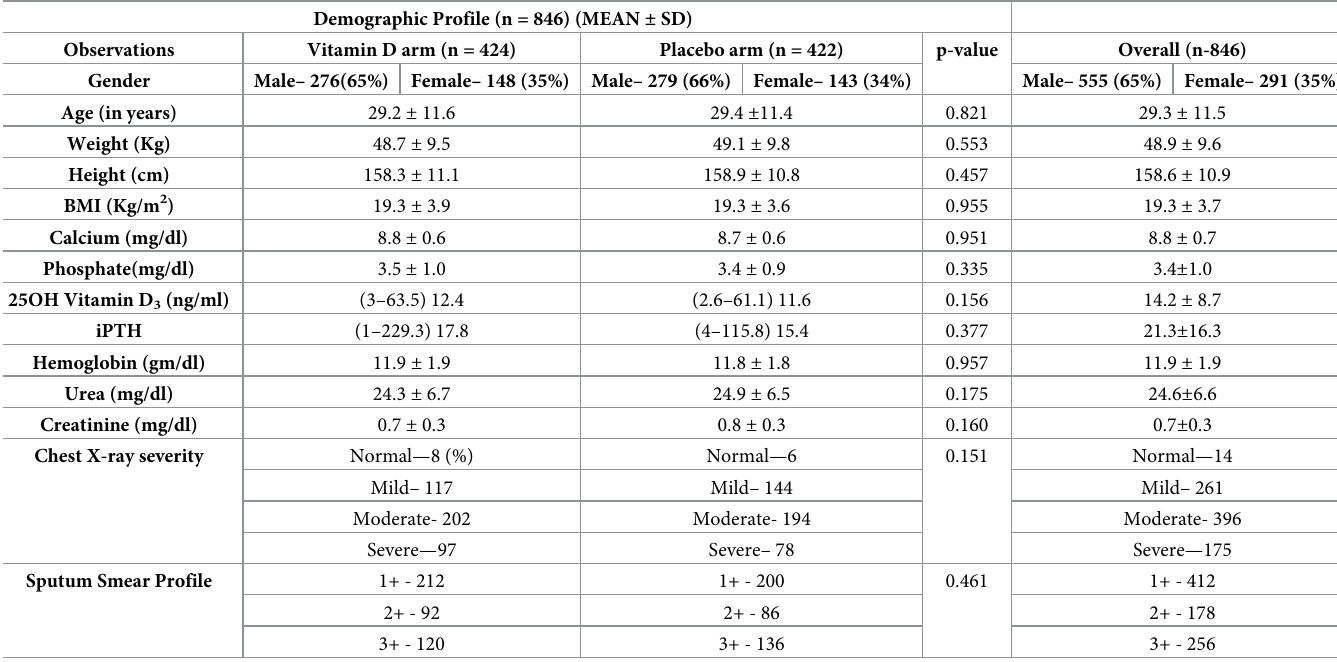
Table 1. Baseline and demographic characteristics.